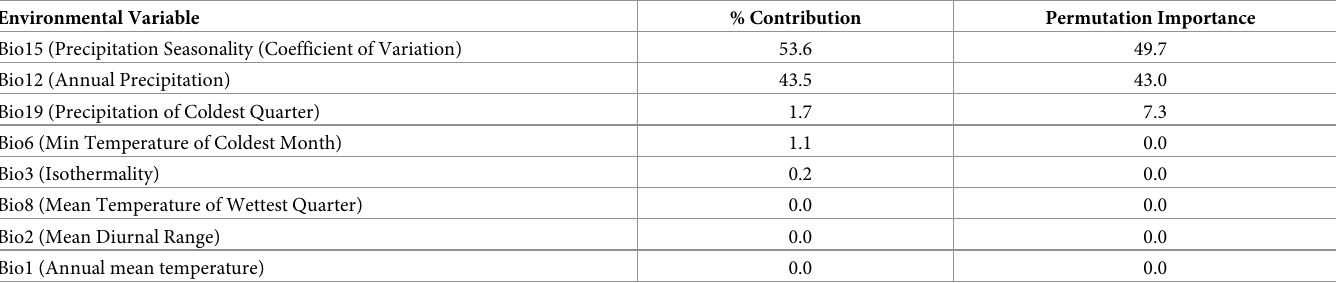
Table 4. Average percent contribution and permutation importance of the variables used in the modeling of O . volvulus infection. Environmental Variable